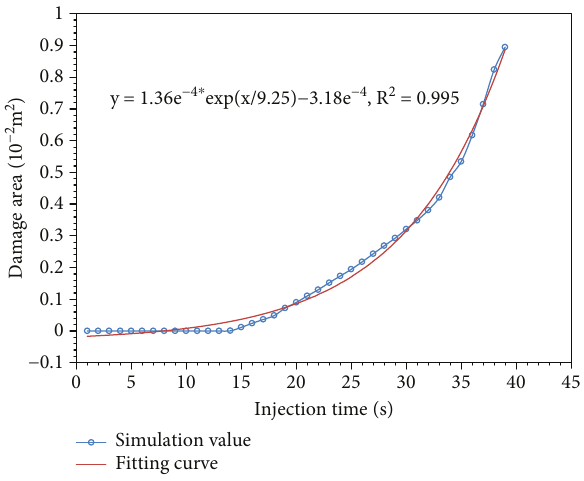
Figure 12: Development of the seepage area versus injection time in the vertical jointed sample.